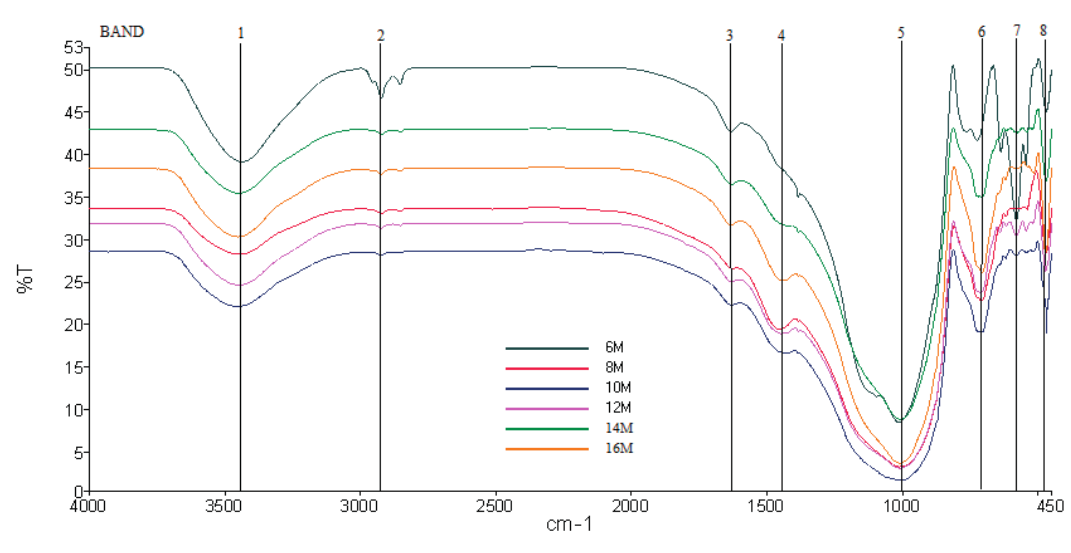
Figure 8. The FTIR spectra of ALGA produced at various NaOH